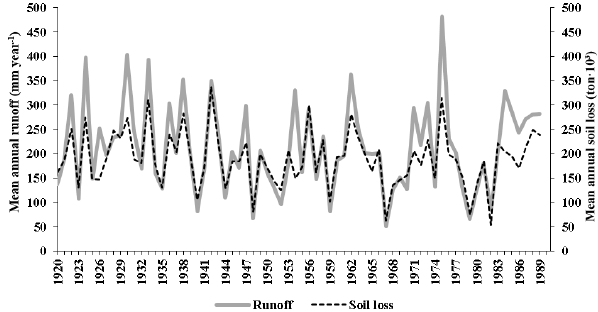
Figure 2. Correlation of runoff and soil loss. Figure 3. Model output for runoff and soil loss for the Ntabelanga Dam